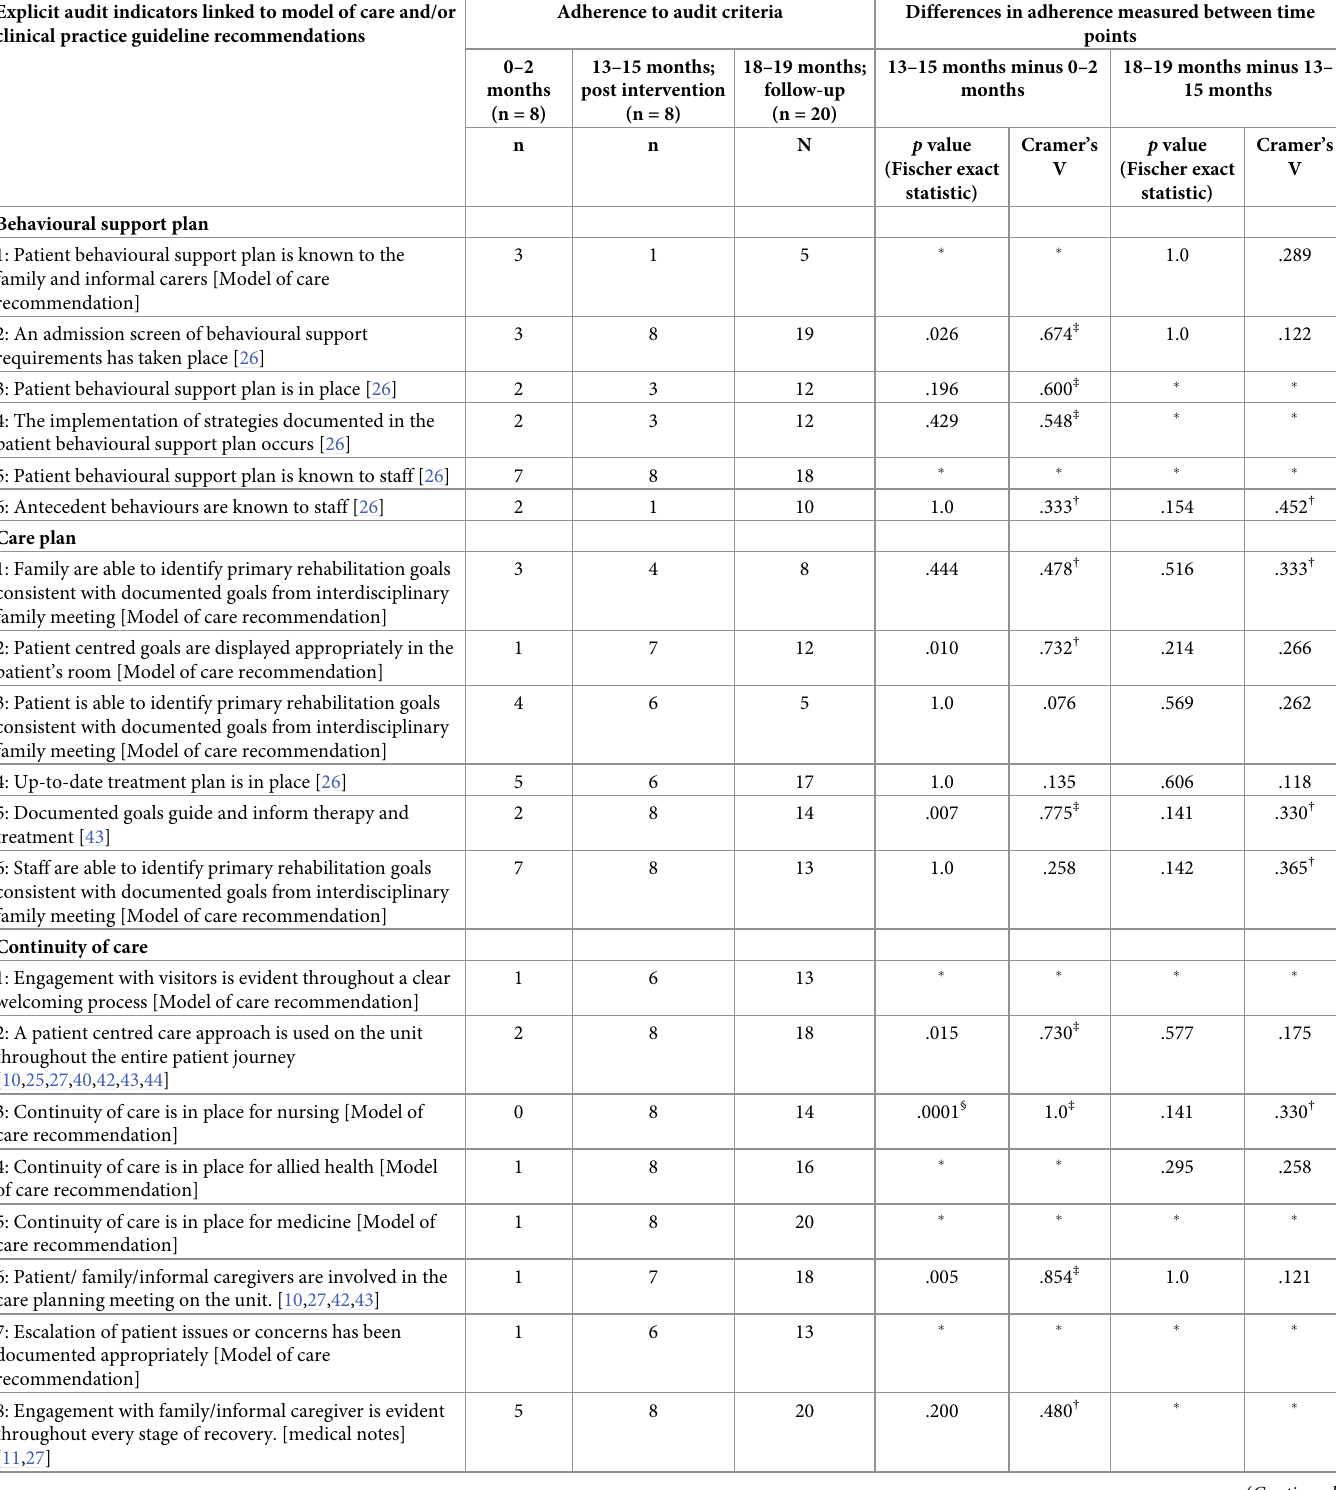
Table 5. Adherence to audited indictors (n = 114) at three audit time points and difference (Chi square) between time points. Explicit audit indicators linked to model of care and/or clinical practice guideline